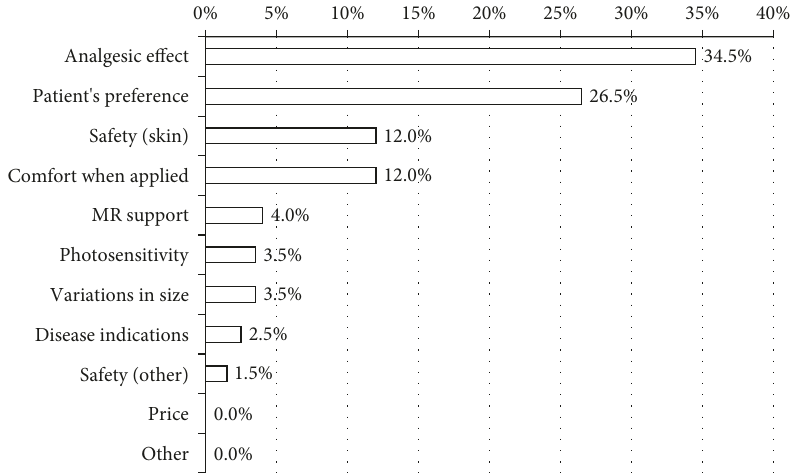
Figure 3: Physician survey: single most desired characteristic of plasters (%, single response, and n (cid:136) 200). Analgesic effect and patient’s preference were the most frequent responses. Cost and systemic adverse effects were lowest in priority. MR: medical